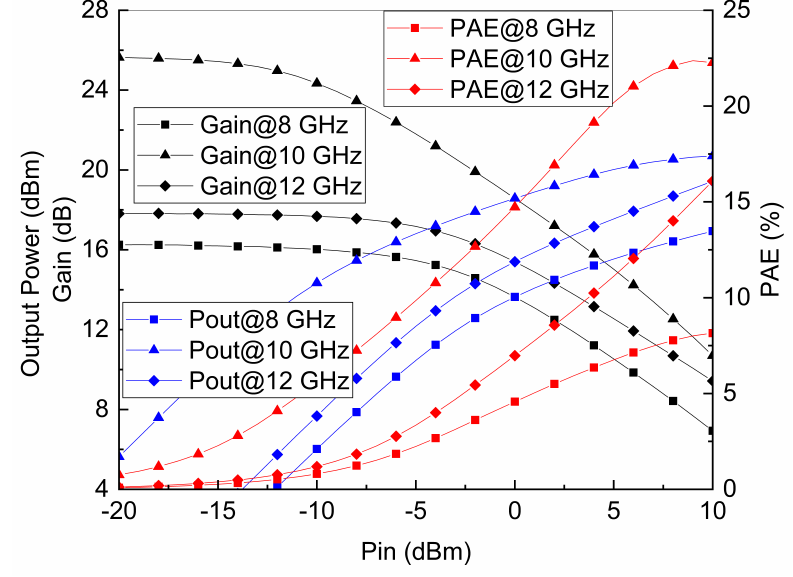
Figure 15. Measured power performance of the X-band PA for frequency range 8–12 GHz in steps of 2 GHz.